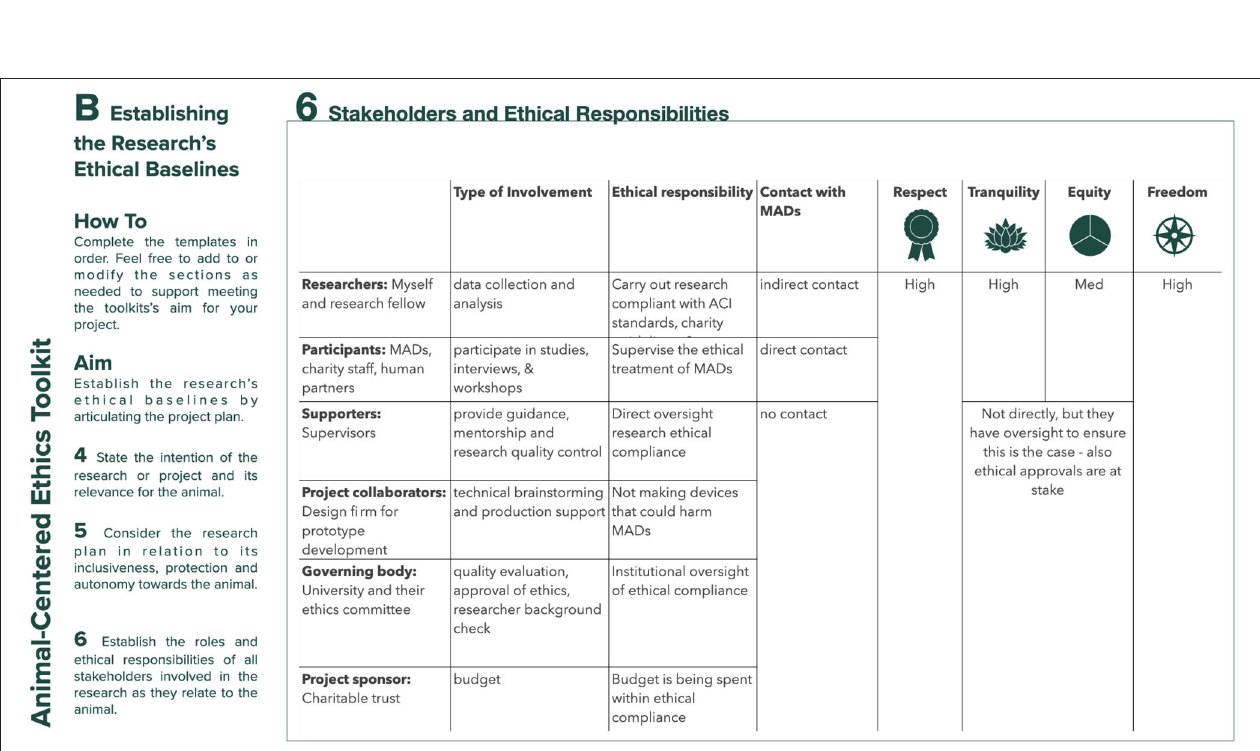
FIGURE 6 | Sample of template B: establishing the research’s ethical baselines for the design of a set of canine-centric controls for Mobility Assistance Dogs, step 6.